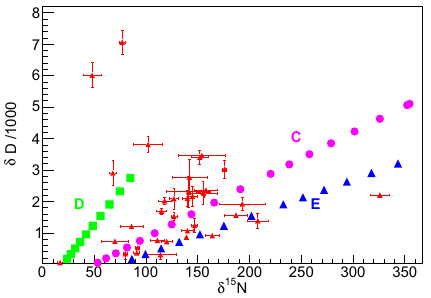
Figure 3. Evolution of δ D vs δ 15 N in a meteoroid with an initial isotopic abundance distribution with an abundance distribution closely matching that of the early solar system and slightly depleted in H, N, O, and Ne